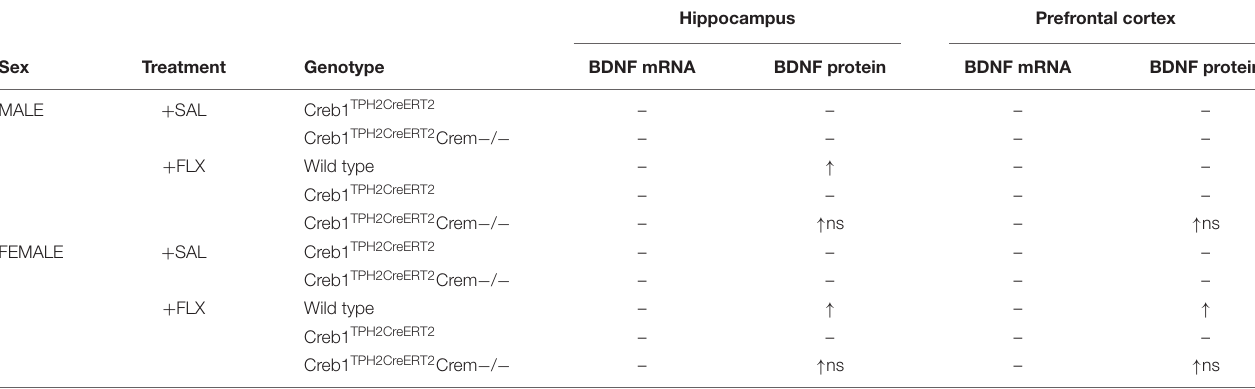
Arrows represent significant changes in BDNF expression vs. saline treated w/t mice. n/s, not significant; SAL, saline; FLX,